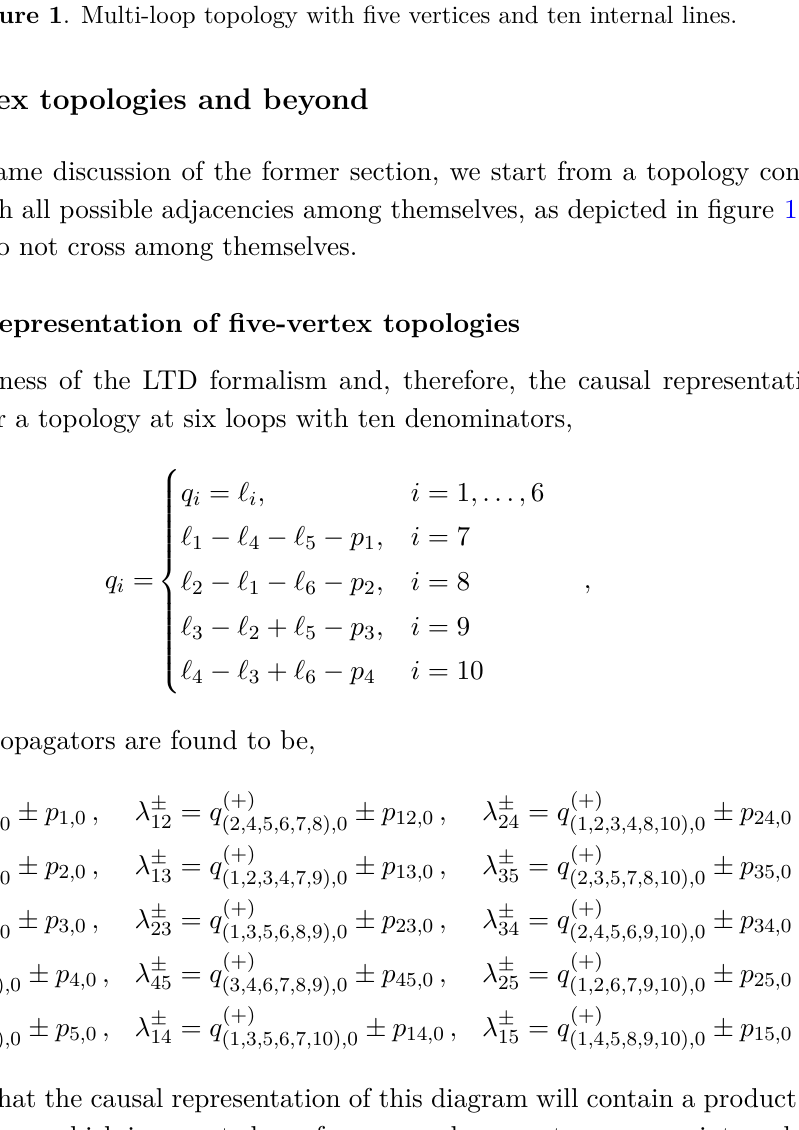
Figure 1 . Multi-loop topology with five vertices and ten internal